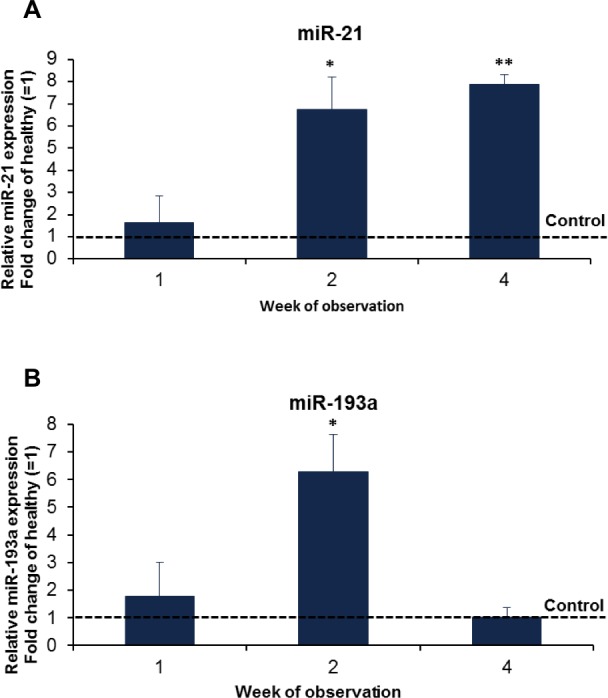
miRNA upregulation upon disease induction.Upregulation of microRNA 21 (A) and microRNA 193a (B) in Nphs2R140Q/- animals (analysis is based on 4–6 animals per group and time point). * p<0.05, ** p<0.001.